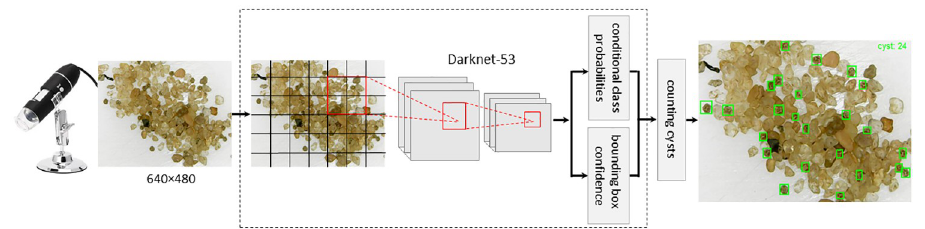
Fig 5. Overview of the automatized approach for Dendrocephalus Brasiliensis cysts detection and counting using YOLOv3.